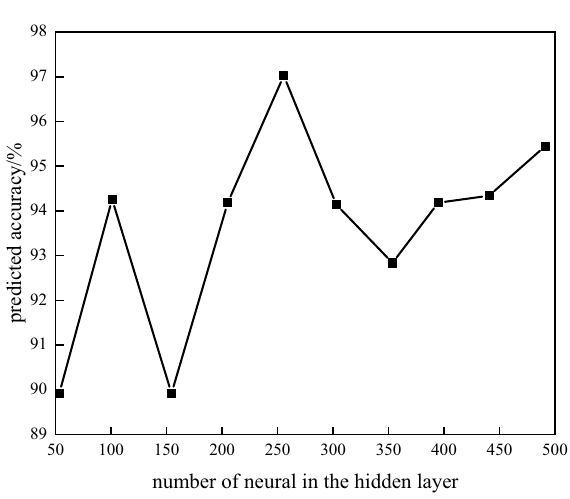
Figure 7. The influence of the number of hidden layer neurons on the performance of